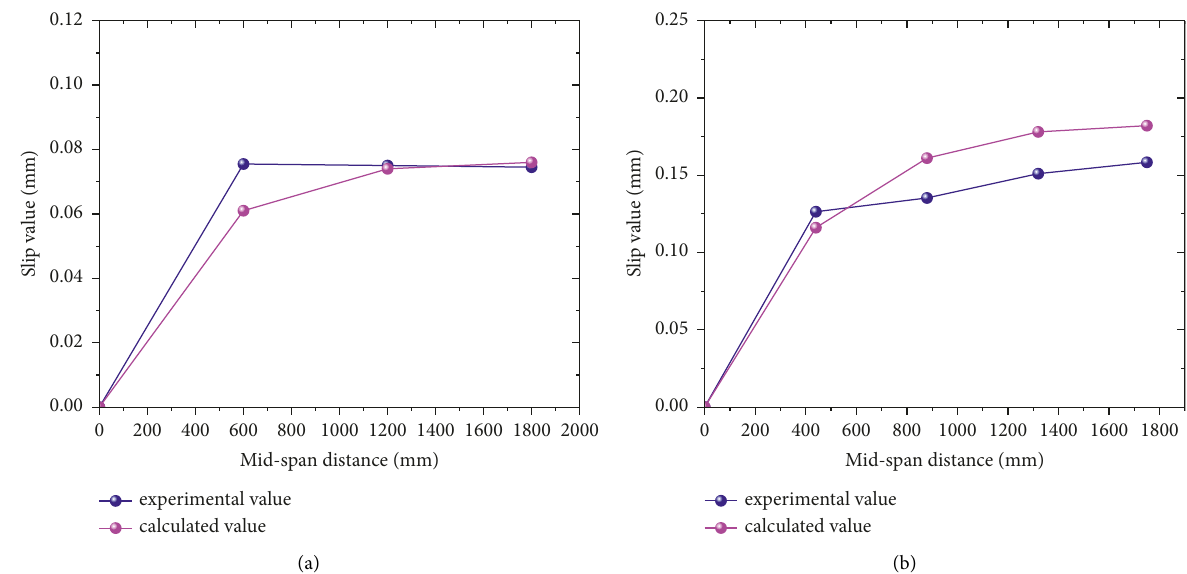
Figure 12: Comparison of slip data of inverted beams. (a) Literature [2]. (b) Literature